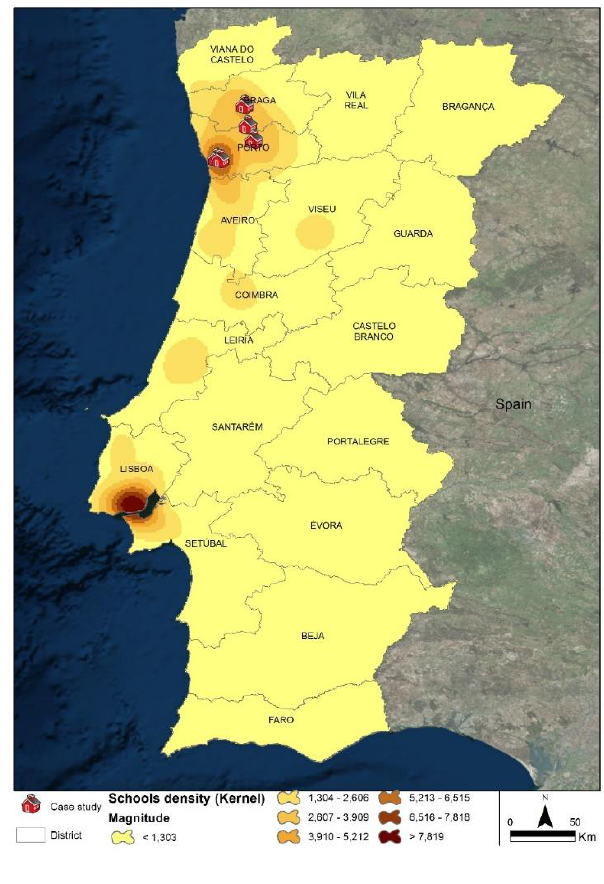
Figure 2. Case study frame